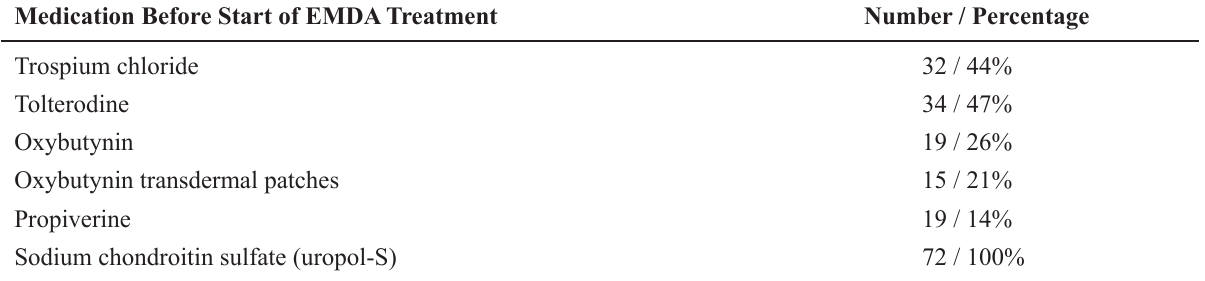
Table 1 – Medications before start of electromotive drug administration (EMDA) treatment. Medication Before Start of EMDA